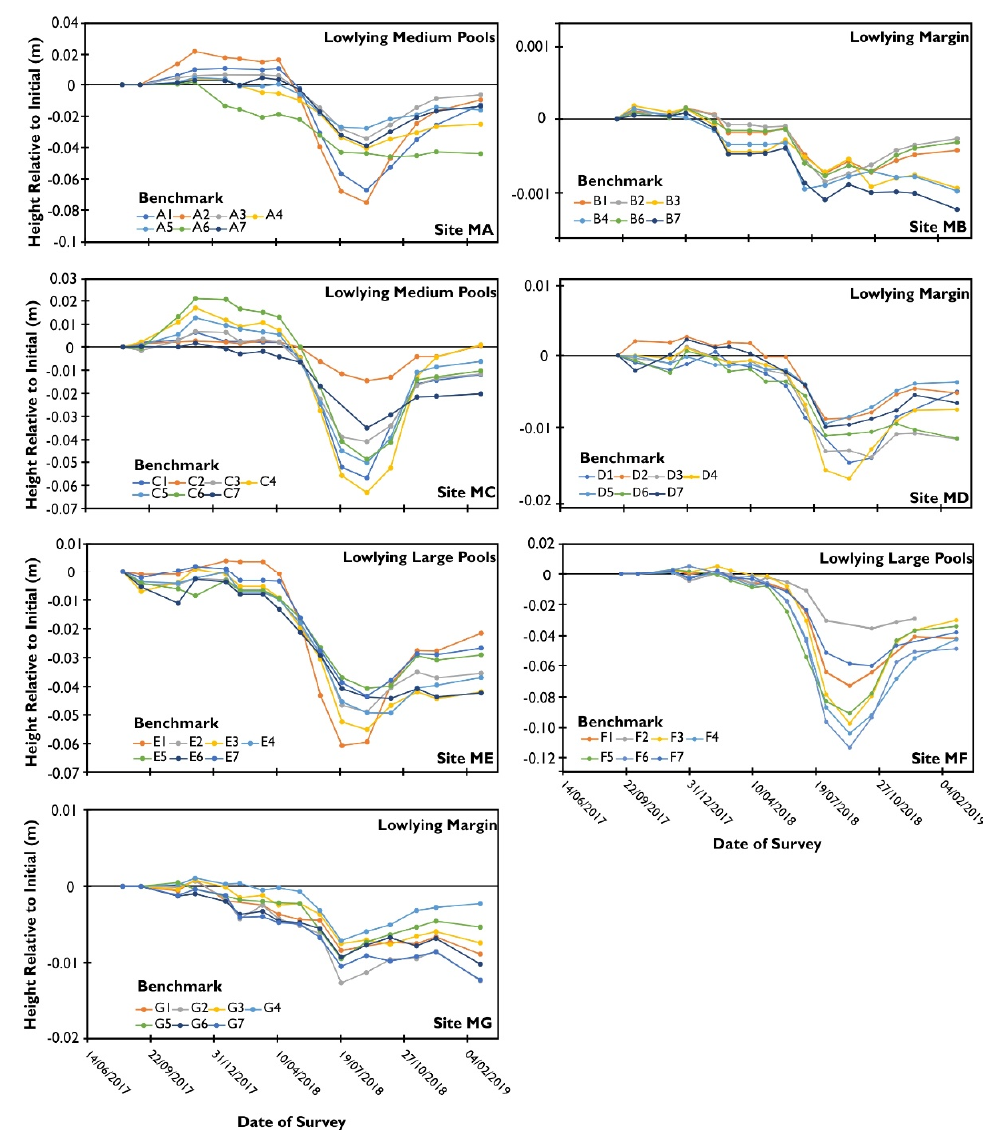
Figure A1. Precise Leveling Timeseries of individual benchmarks at subsites (Sites M A – G ) at the Low-lying Munsary Site.